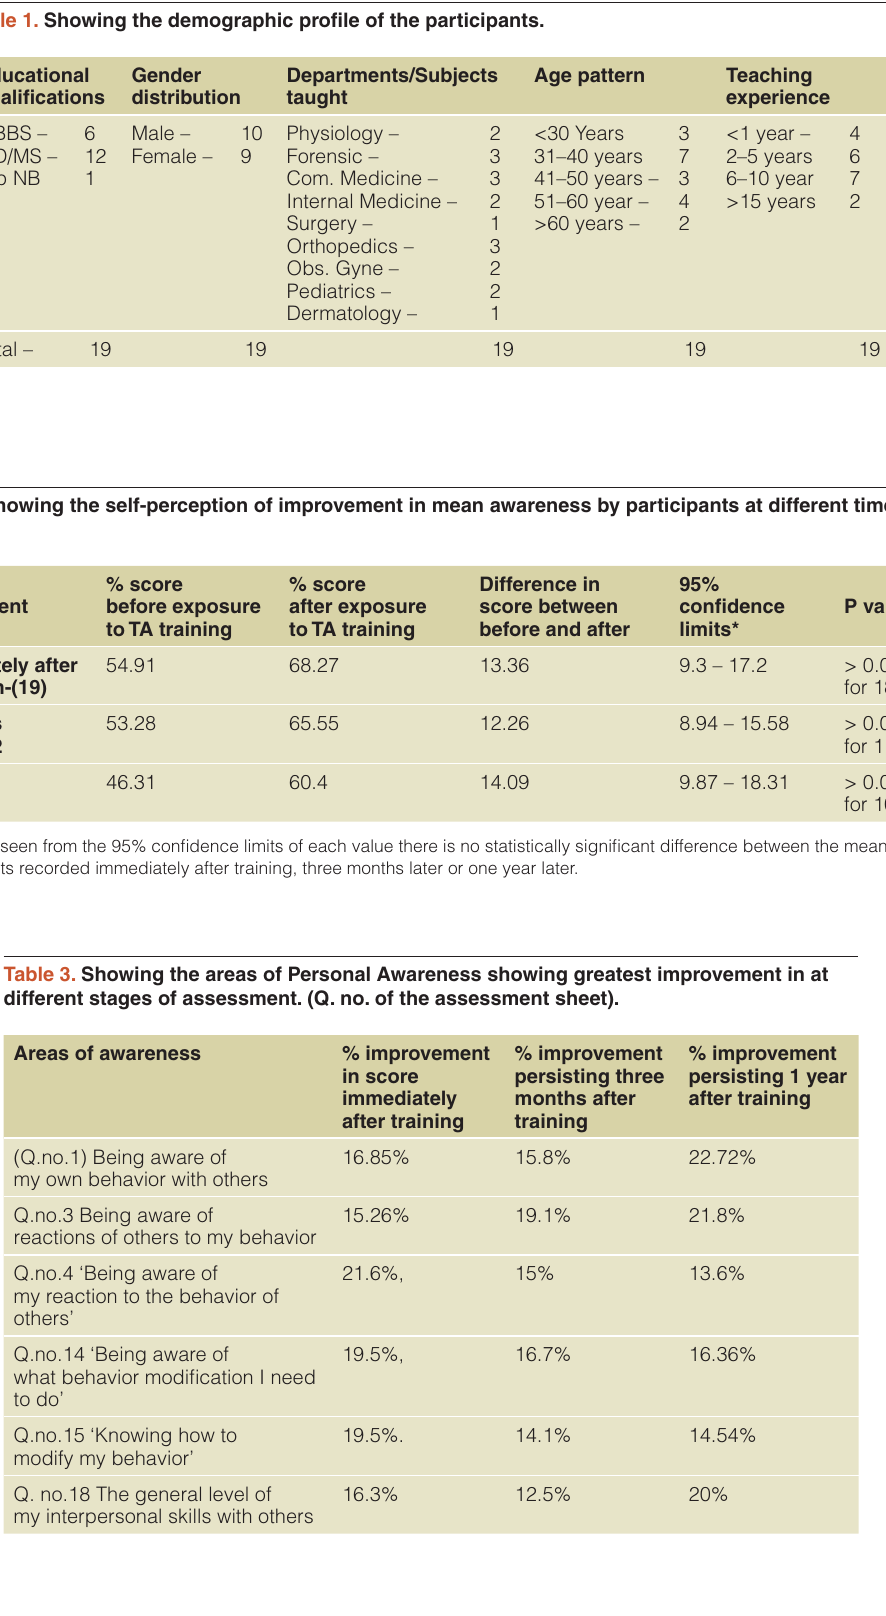
Table 1. Showing the demographic profile of the participants.